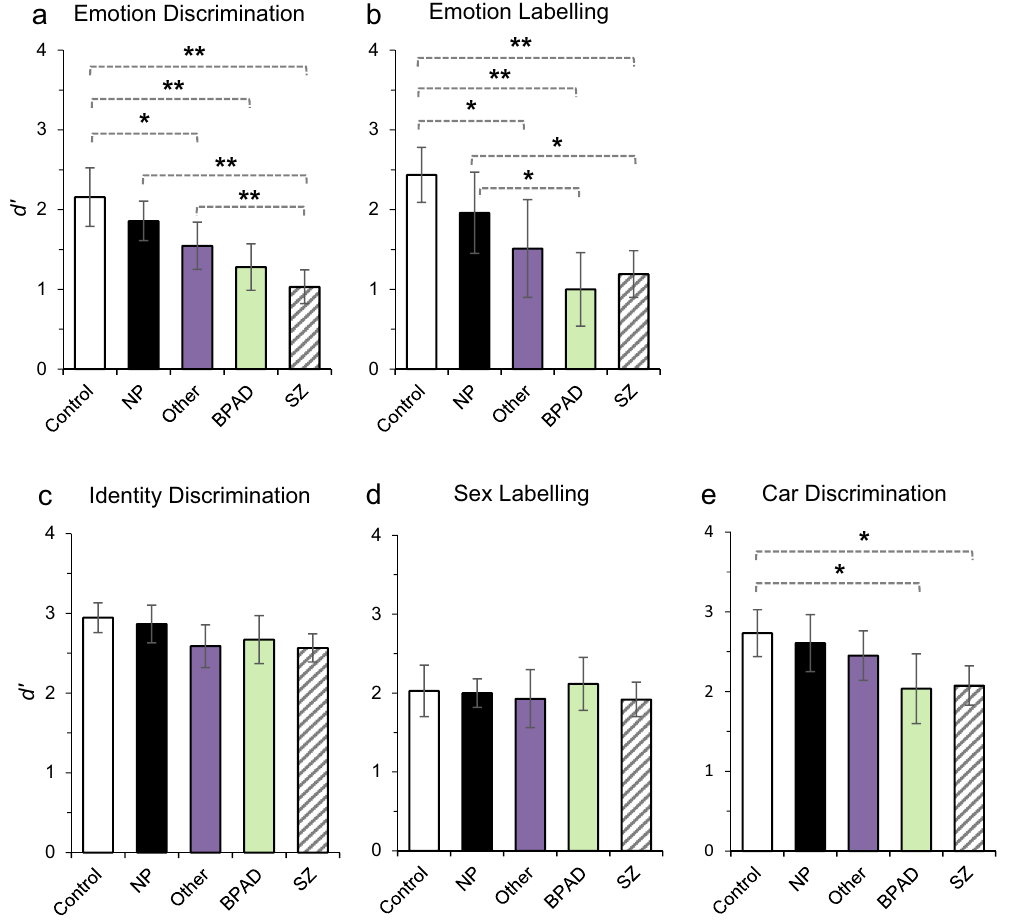
Fig. 2 Mean d ’ performance for the schizophrenia spectrum (SZ), BPAD, other psychosis (Other), non-psychosis (NP) and control groups across fi ve tasks. A higher d ’ value indicates better performance. Signi fi cant differences between groups are indicated with dotted lines, ** p < 0.01; * p < 0.05. Error bars represent 95% con fi dence intervals. Table 2. Pearson correlations between PANSS scores and d prime performance on the fi ve dynamic tasks. Emotion discrimination Emotion